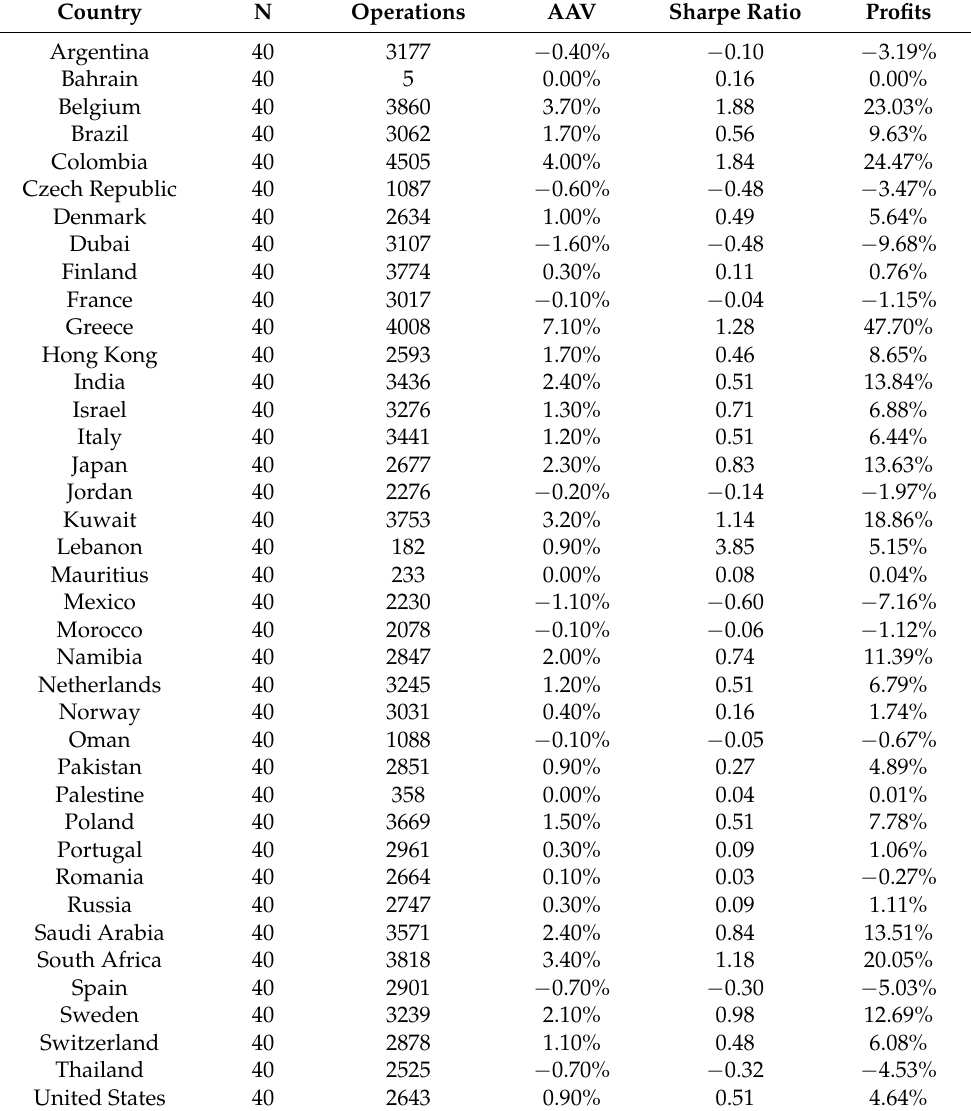
Table A9. Results obtained for the period 2014–2020 (40 Pairs), where N is the number of pairs; AAV Average annualized return; and Profit is the profitability for the full period with transaction